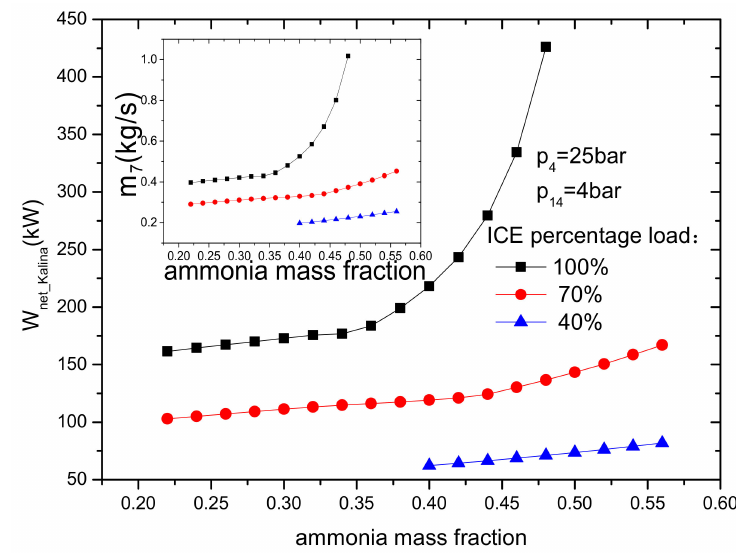
Figure 9. Effects of ammonia mass fraction on W net_Kalina .